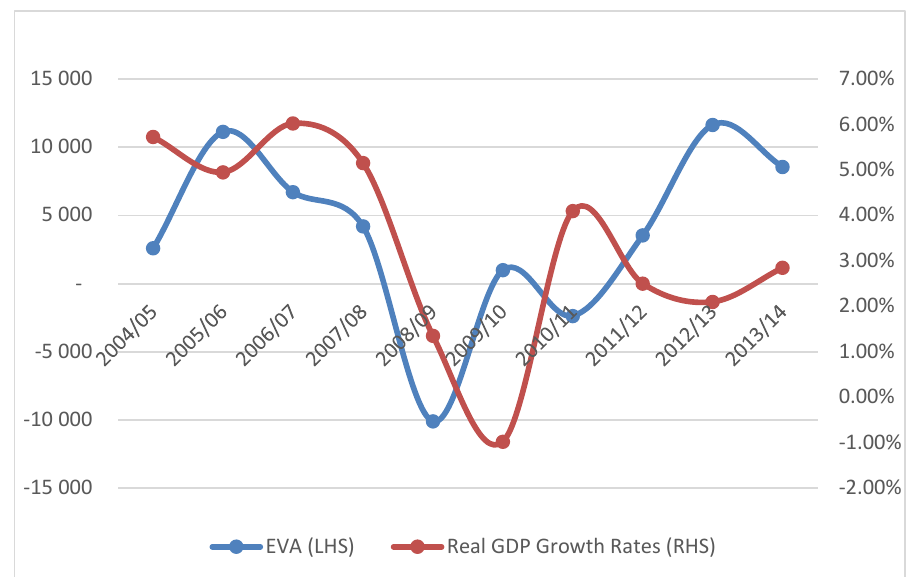
FIGURE 1: Industry EVA versus SA GDP growth rates for the past 10 years Source: Statistics SA, authors’